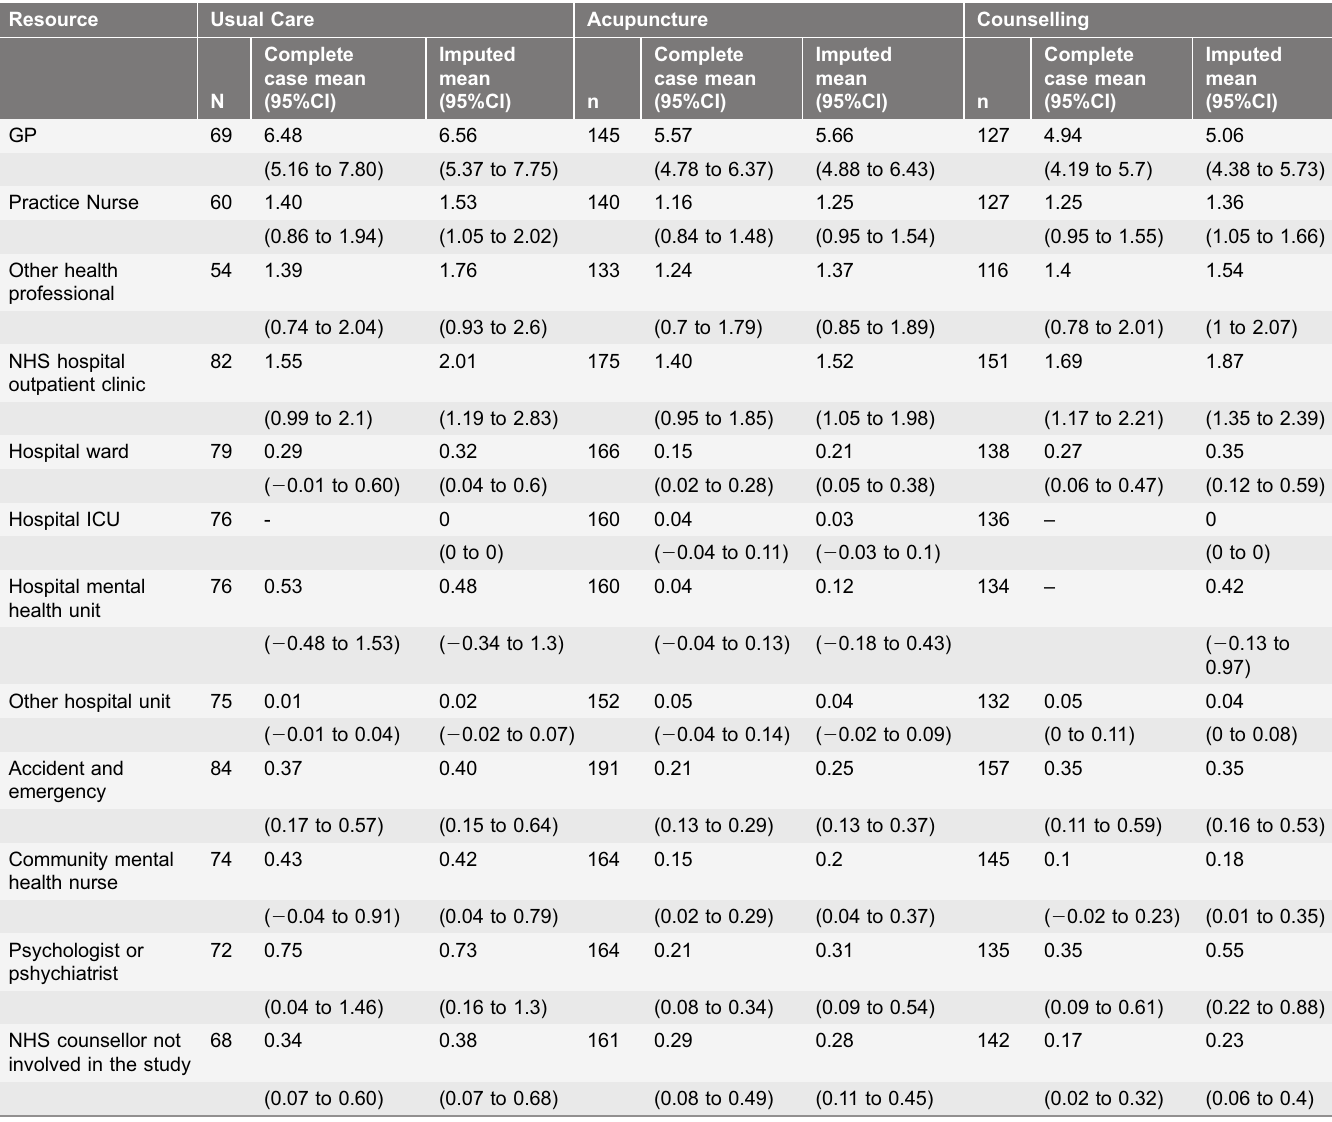
Table 2. Complete case and imputed mean number of service use contacts over 12